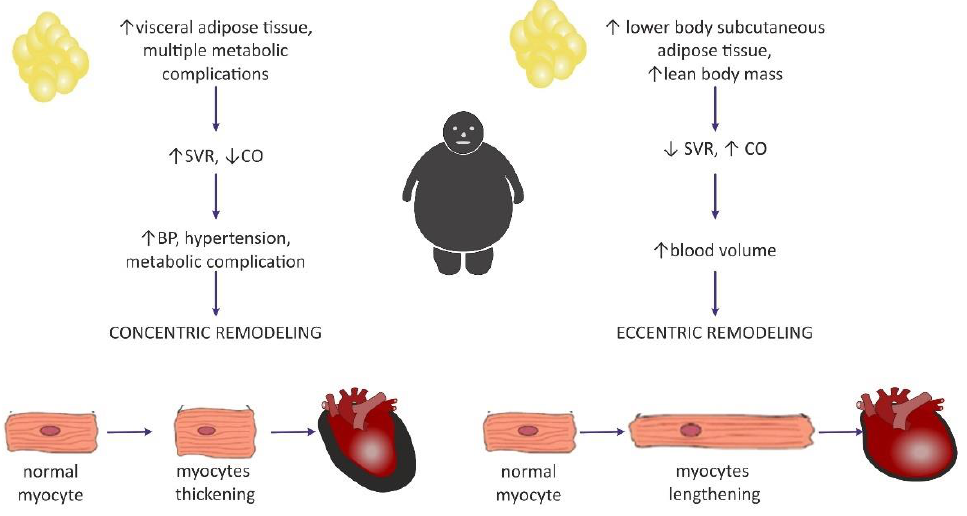
Figure 2. Two distinctive patterns of cardiac remodeling in the course of obesity and a proposition for their pathogenesis based on adipose tissue distribution. SVR — systemic vascular resistance; CO — cardiac output.